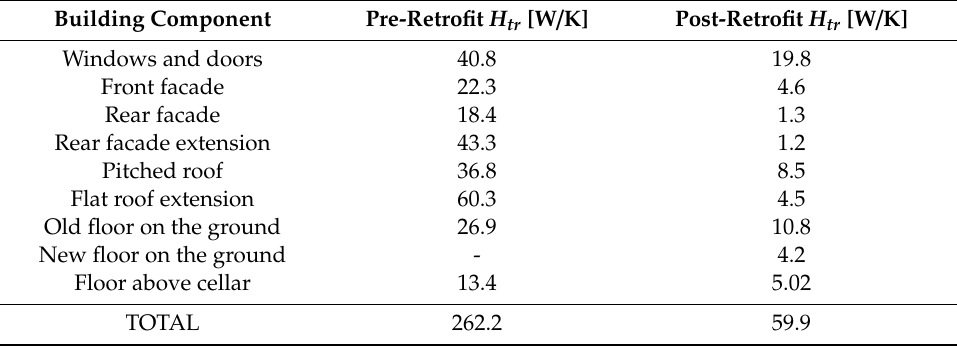
Table 5. Transmission heat losses towards the